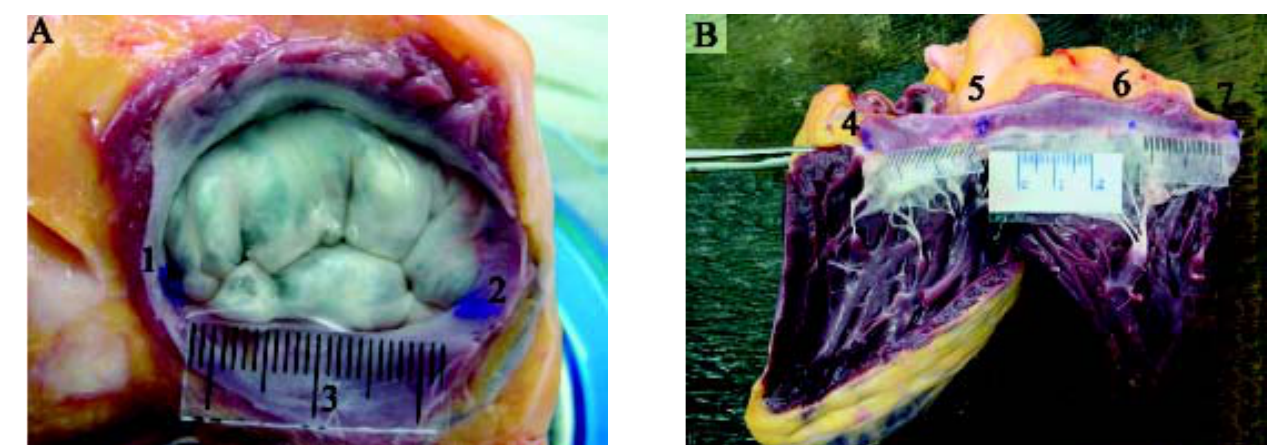
Fig. 3 - A) Valva tricúspide continente e com anel íntegro (1- marcação da comissura ântero-septal; 2- marcação da comissura póstero- septal; 3- escala milimetrada no mesmo plano da valva). B) Valva tricúspide com anel retificado (4 e 7- marcações da comissura póstero- septal, dividida pela incisão que retifica o anel valvar; 5- marcação da comissura ântero-septal; 6- marcação da comissura